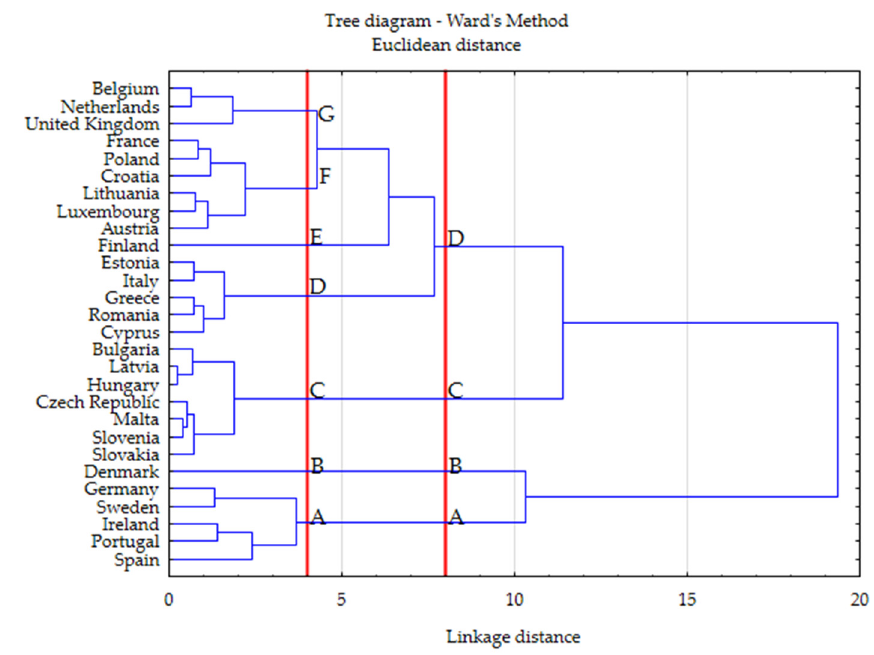
Figure 6. Tree diagram—division of the EU countries into clusters.